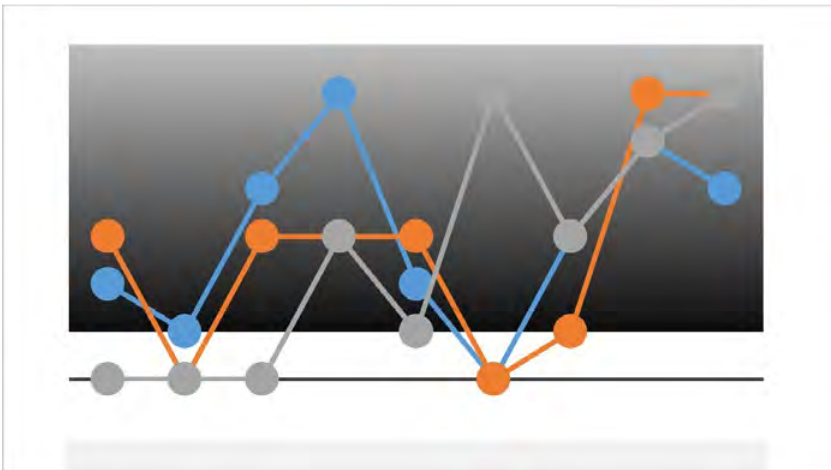
Figure 19. The result of the